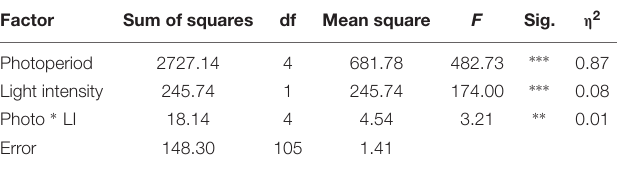
TABLE 1 | Analysis of variance of Setaria viridis flowering time differences between the five photoperiod and two light intensities (see Materials and Methods), showing significant effects for both factors and their